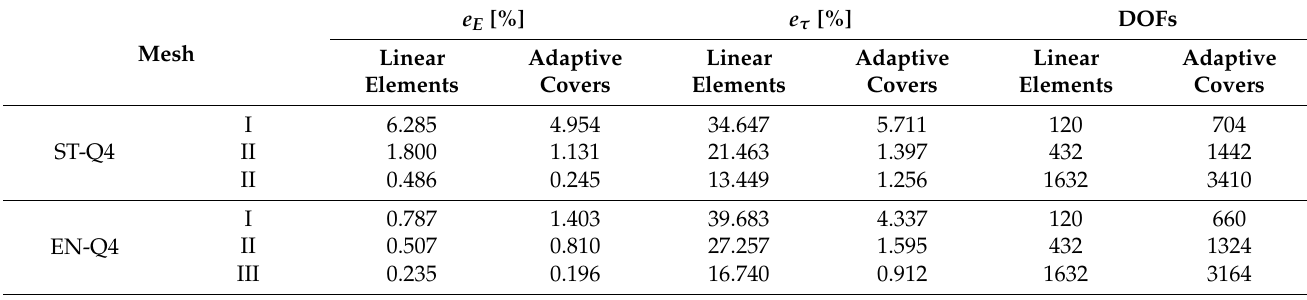
Table 5. Relative errors (%) in the energy norm ( E ) and the maximum von Mises stress ( τ ) in the L-shape structure problem when the meshes of quadrilateral elements (ST-Q4, ES-Q4) are